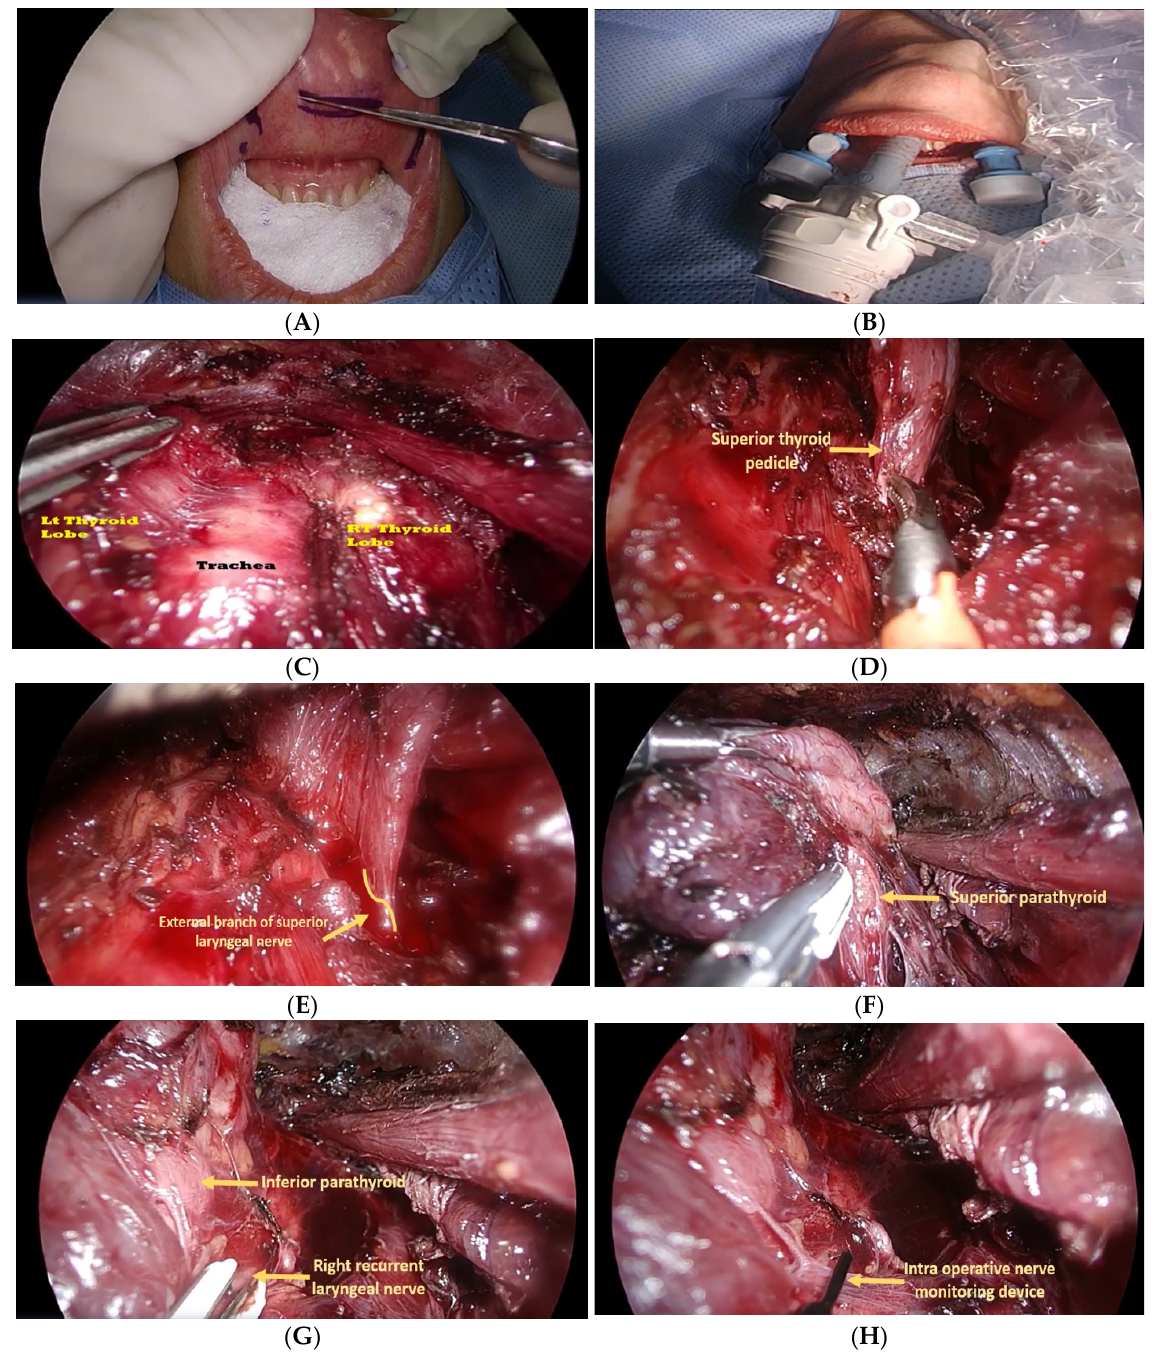
Figure 1. Surgical steps during the transoral vestibular thyroidectomy ( A ), marking for incisions and trocar placements ( B ), placement of a midline 10 mm and two 5 mm ports ( C ), endoscopic view of the thyroid lobes and trachea. Identification of the superior thyroid pedicle ( D ), the external branch of the superior laryngeal nerve ( E ), the superior parathyroid gland ( F ), the inferior parathyroid gland and the recurrent laryngeal nerve ( G ) and the use of intraoperative nerve stimulator ( H ).